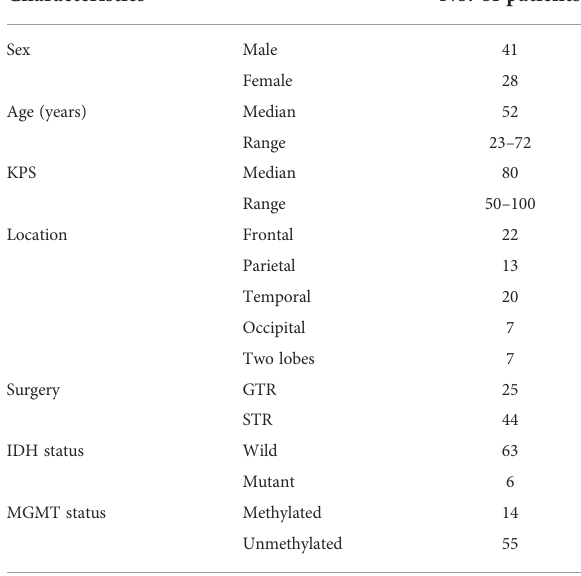
TABLE 2 Baseline characteristics of the patients.